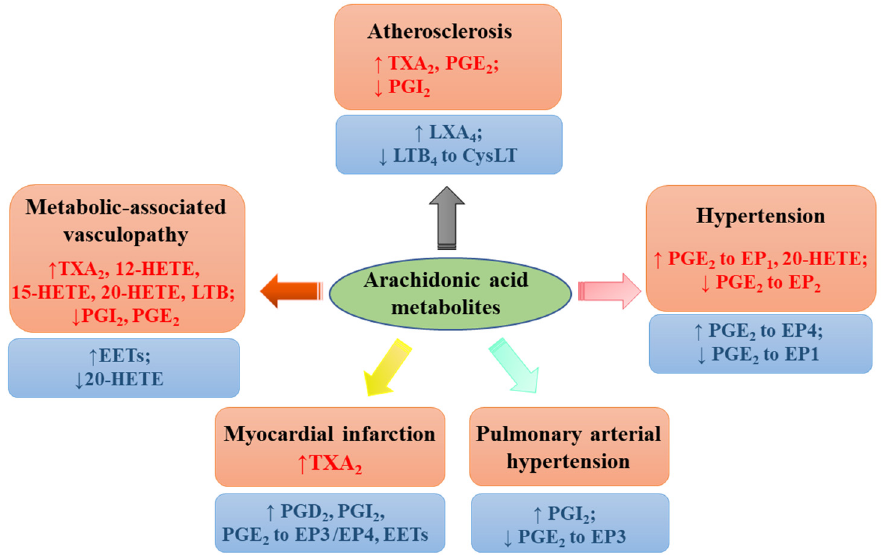
Figure 4. Effects of arachidonic acid metabolites on cardiovascular diseases. Various metabolites including prostaglandin (PG)D 2 and PGE 2 (to EP1, EP2, EP3 or EP4 receptor), prostacyclin (PGI 2 ), thromboxane (TX)A 2 , leukotrienes B4 (LTB 4 ) (to CysLT receptors), lipoxin A 4 (LXA 4 ), hydroxyeicosatetraenoic acids (HETEs), and epoxyeicosatrienoic acids (EETs) exert vasoprotective (labeled with blue color) and deteriorative effects (labeled with red color).